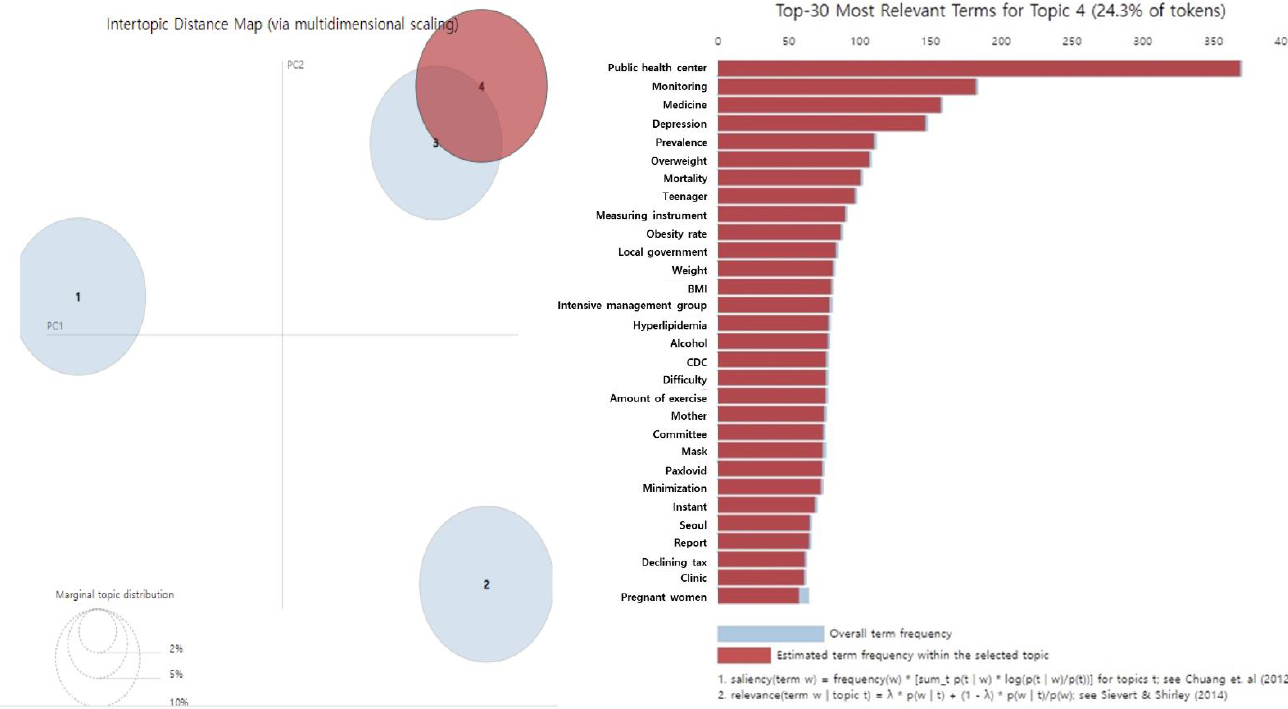
Figure 4. Results of LDA topic modeling ‘Topic 4’ in people with diabetes during the COVID -19